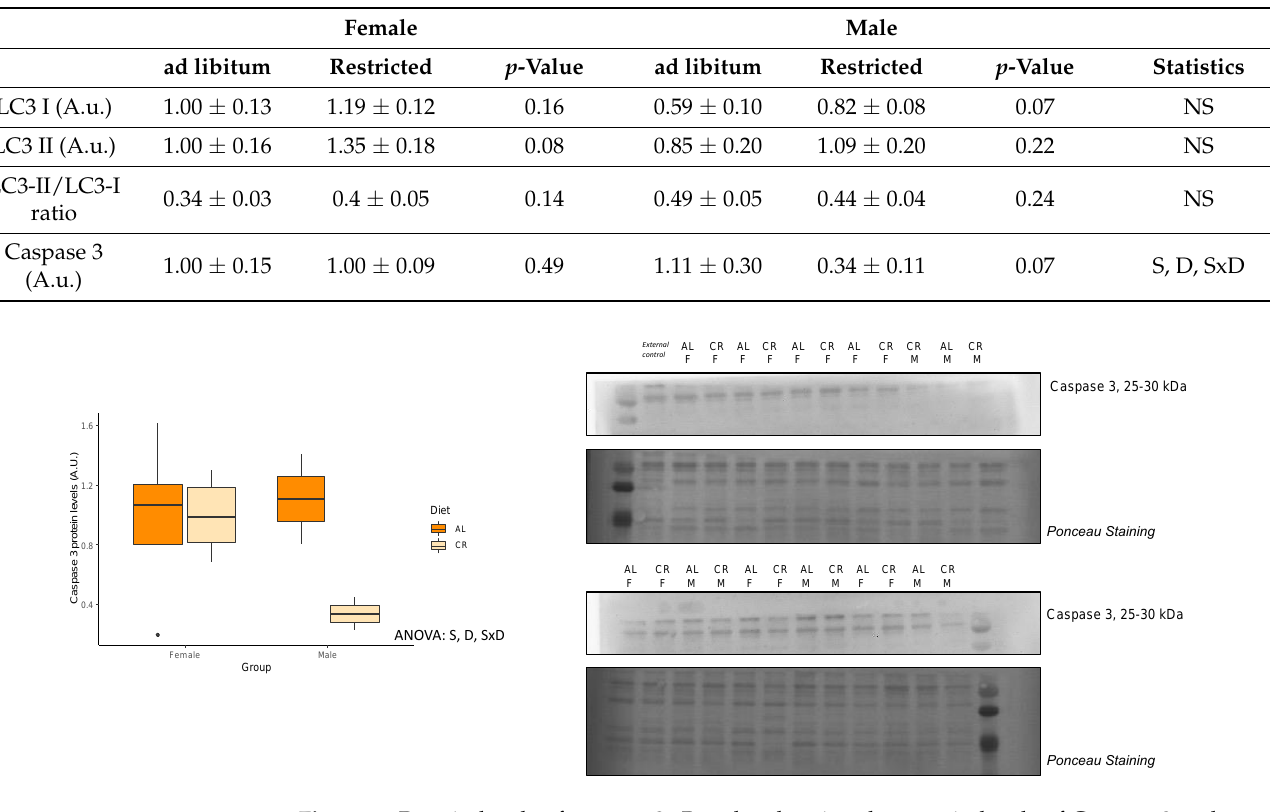
Table 5. mRNA expression levels of autophagy markers. Two-way ANOVA was performed to assess for significance. Abbreviations: NS, non-significant; Map1lc3a , microtubule-associated protein 1 light chain 3 alpha; Sqstm1 : sequestosome 1.